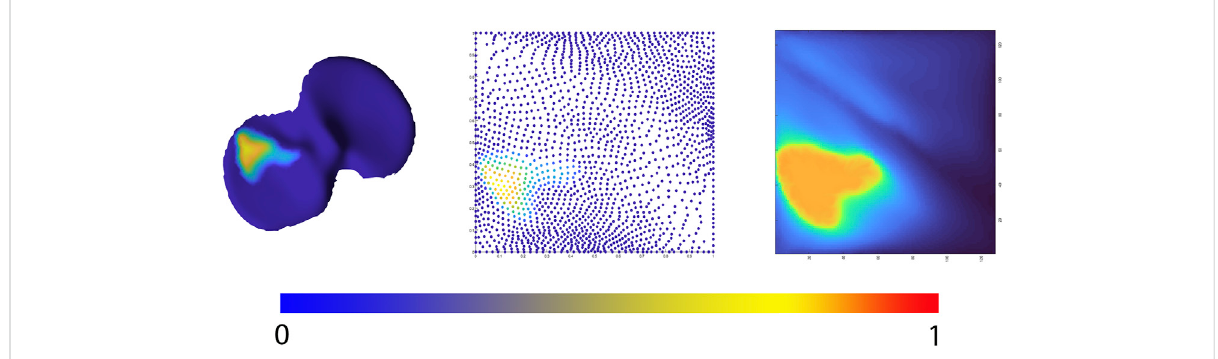
FIGURE 4 Representation of the 2D joint space mapping work fl ow. Starting from an anatomically standardized distance map (left) a 2D parameterization (center) is developed. Spline-based interpolation provides a pixel image (right). The continuum from intact cartilage towards complete cartilage erosion is color-coded, ranging respectively from blue = 0 (completely intact cartilage) to red = 1, (complete cartilage